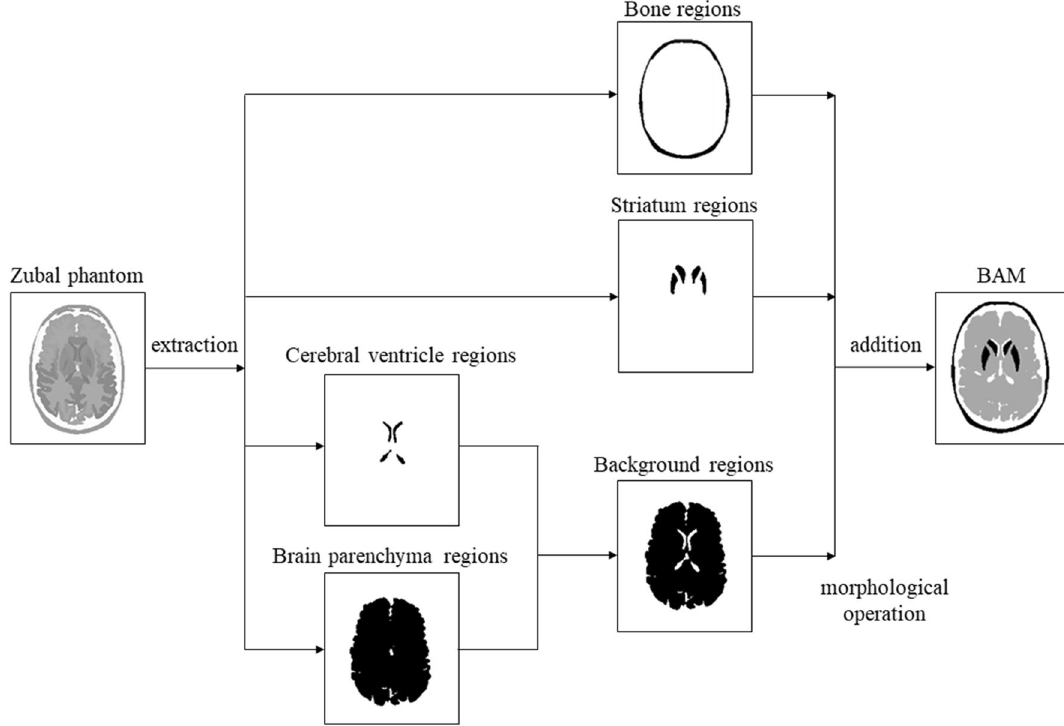
Figure 1. At first, four areas were extracted from the magnetic resonance imaging based Zubal head phantom. Next, the background regions were created by differentiating the cerebral ventricle regions from the brain parenchyma regions. Finally, brain atrophy model (BAM) was generated by combining bone, striatum, and background regions subjected to the morphological operation.